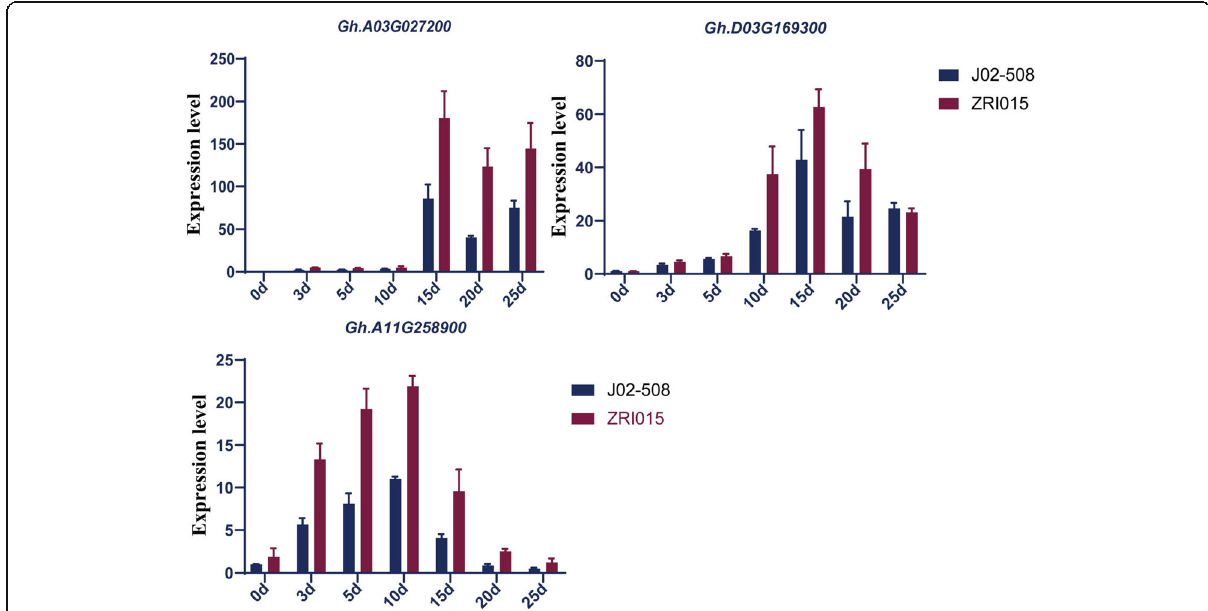
Fig. 6 RT-PCR analysis of expression levels of three key tubulin genes in different stages of ovules (0d, 3d) and fibers(5d, 10d, 15d, 20d,